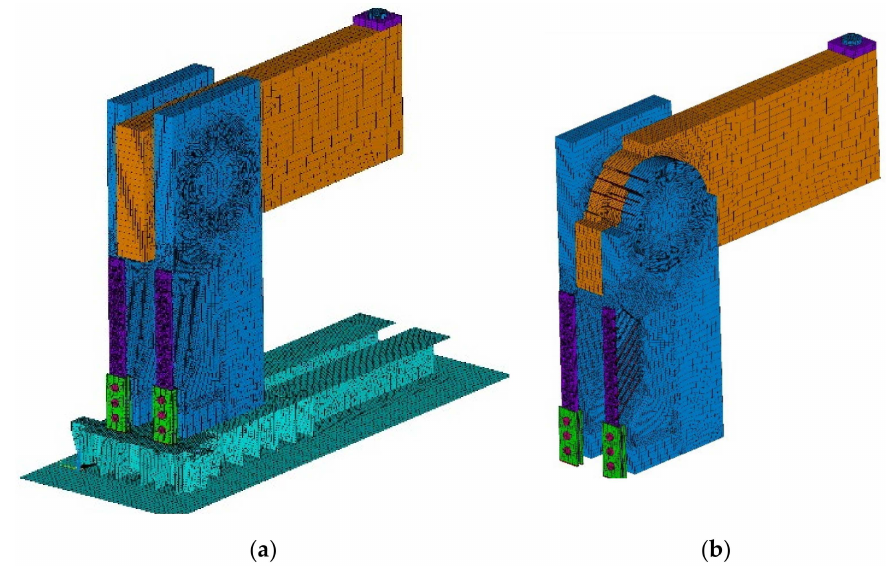
Figure 11. The 3D computational model: ( a ) total model; ( b ) part of the